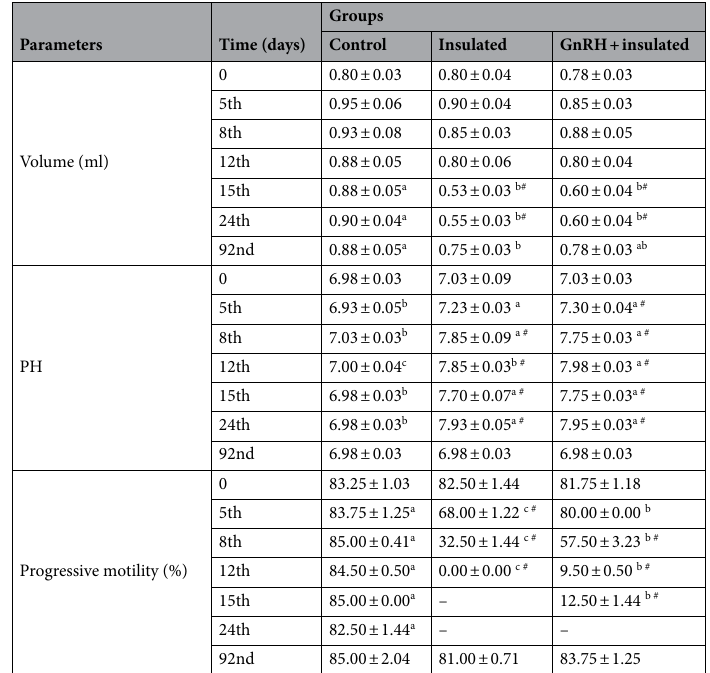
Table 2. Interactions between time and treatment groups on seminal parameters from bucks subjected to scrotal insulation (INS and GnRH + INS) or not (CON) for 92 days of insulation. a,b,c Means with different small superscript letters in the same row are significantly different ( p < 0.05) (Duncan test). # Significant different as compared to zero time in the same group (Paired T-